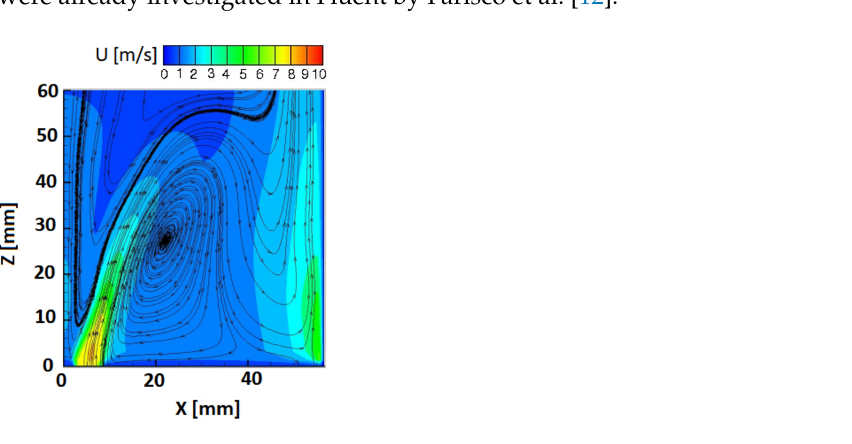
Figure 7. Velocity magnitude profile for the cold flow case with RNG k- (cid:101) turbulence